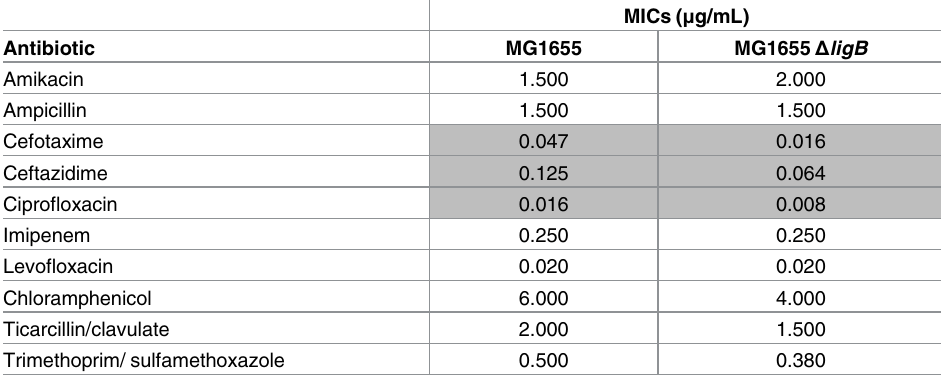
Table 1. Effect of ligB deletion on antibiotic